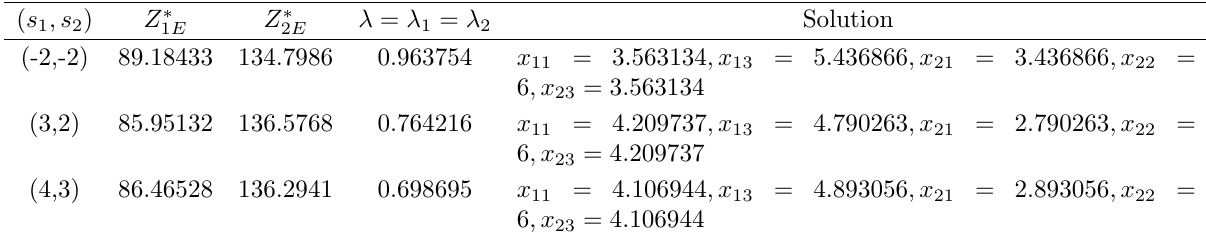
Table 2. Solution table for ( s 1 , s 2 ) in the exponential membership function for EV Model-5.